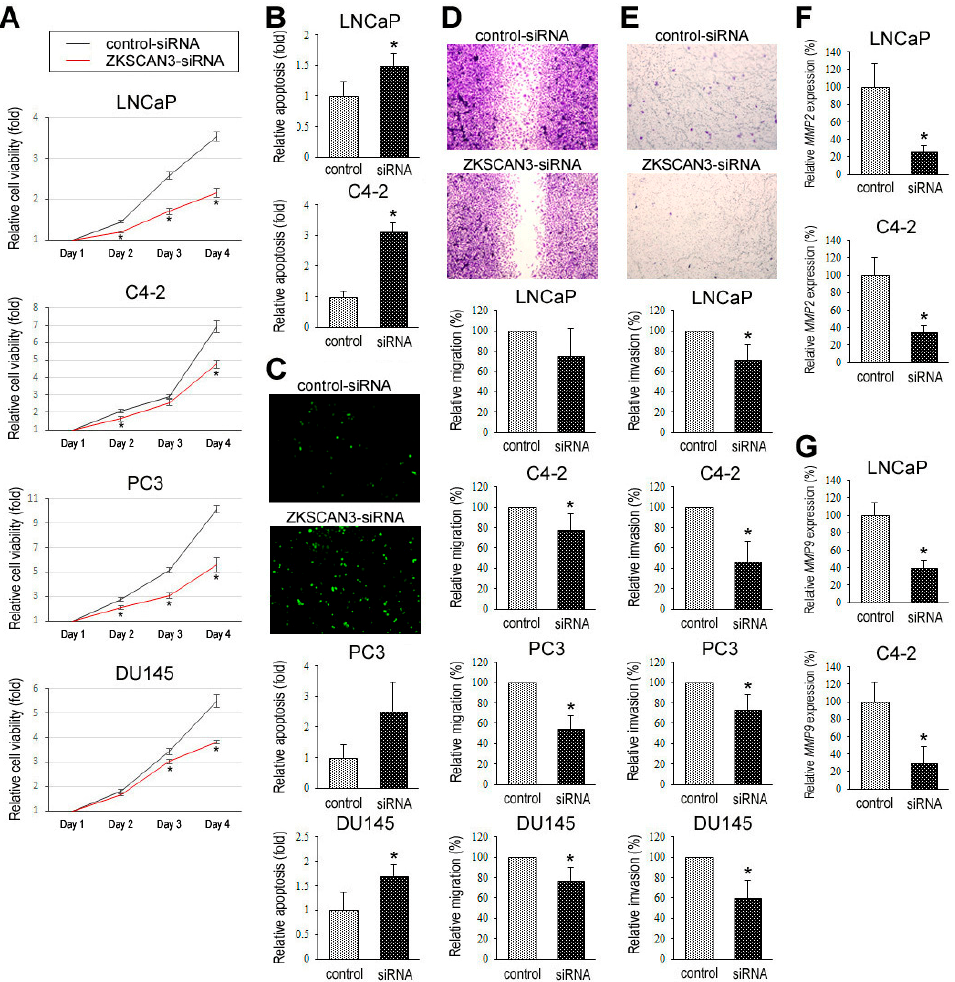
Figure 5. Effects of ZKSCAN3 silencing on prostate cancer cell growth. ( A ) MTT assay in 4 prostate cancer cell lines transfected with either control-siRNA or ZKSCAN3-siRNA and cultured for 1–4 days. Cell viability is presented relative to that of each control line at day 1. Each value represents the mean (+SD) of 5 determinants. * p < 0.05 (vs. control-siRNA). Flow cytometry ( B ) and TUNEL assay ( C ) in 2 prostate cancer cell lines transfected with either control-siRNA or ZKSCAN3-siRNA. Apoptosis is presented relative to that of each control line. Each value represents the mean (+SD) of 3 determinants. * p < 0.05 (vs. control-siRNA). ( D ) Wound-healing assay in 4 prostate cancer cell lines transfected with either control-siRNA or ZKSCAN3-siRNA. The cells grown to confluence were gently scratched and the wound area was measured after 24-h culture. The migration determined by the rate of cells filling the wound area (24 h/0 h) is presented relative to that of each control line. Each value represents the mean (+SD) from 3 independent experiments. * p < 0.05 (vs. control-siRNA). ( E ) Transwell invasion assay in 4 prostate cancer cell lines transfected with either control-siRNA or ZKSCAN3-siRNA and cultured in the Matrigel-coated transwell chamber for 24 h. The number of invaded cells present in the lower chamber was counted under a light microscope (100× objective in 5 random fields). Cell invasion is presented relative to that of each control line. Each value represents the mean (+SD) from 3 independent experiments. * p < 0.05 (vs. control-siRNA). Quantitative real-time RT-PCR of MMP2 ( F ) or MMP9 ( G ) in 2 prostate cancer cell lines transfected with either control-siRNA or ZKSCAN3-siRNA. The expression of each specific gene was normalized to that of GAPDH , and transcription amount is presented relative to that in each control line. Each value represents the mean (+SD) of 6 determinants. * p < 0.05 (vs. control-siRNA).